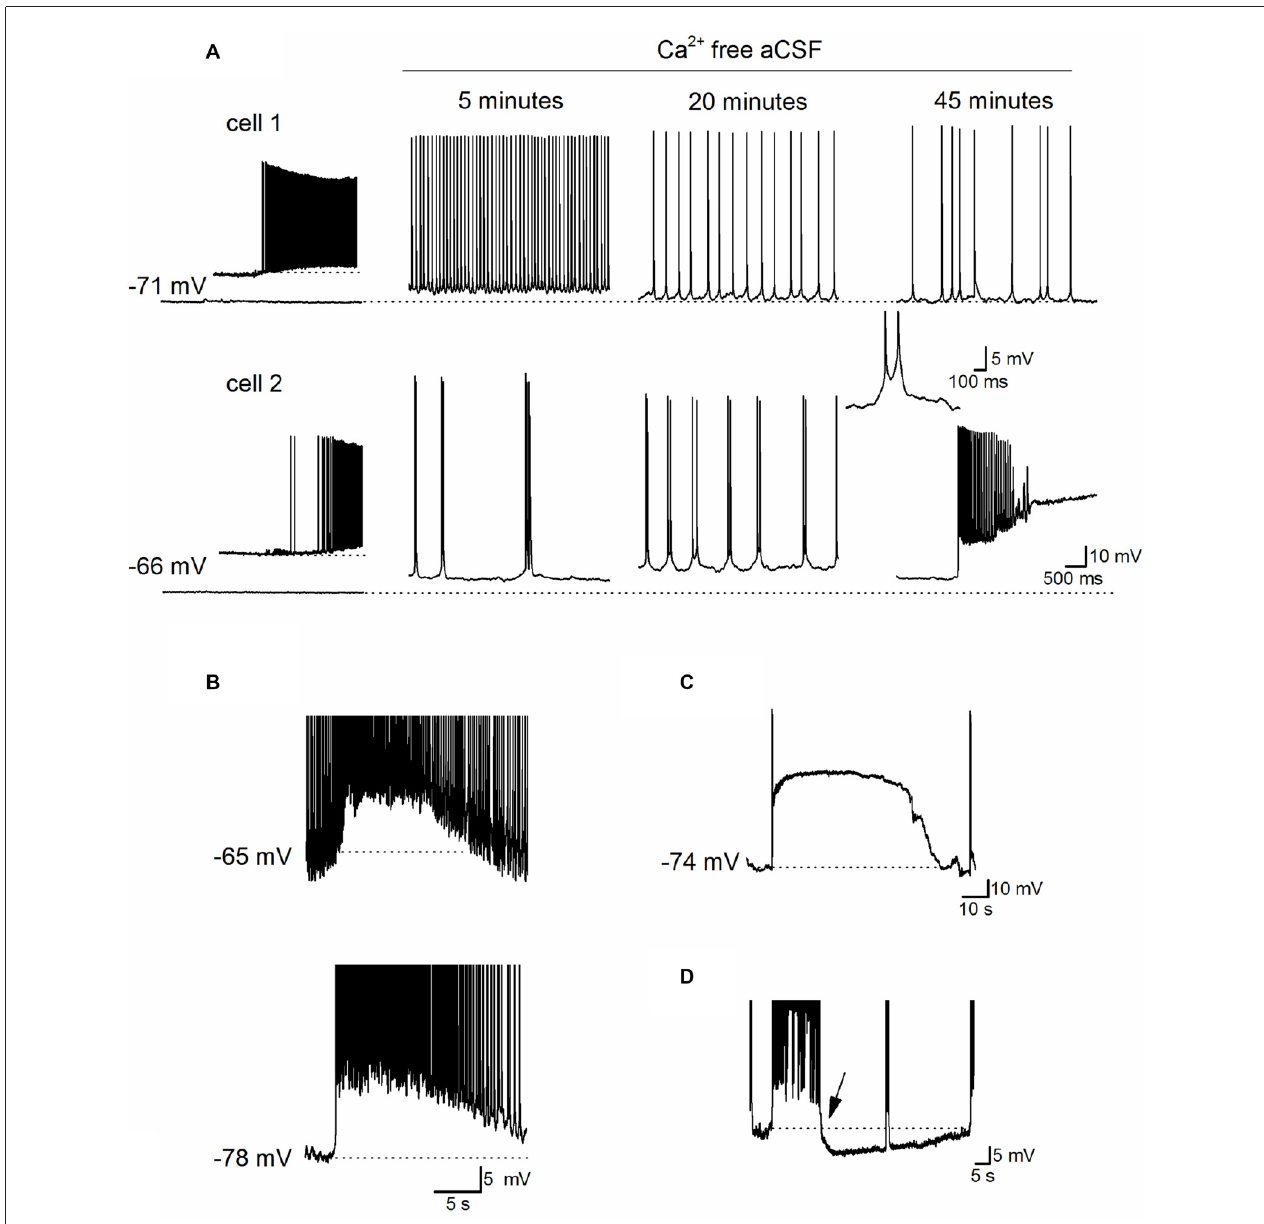
FIGURE 1 | Characterization of Ca 2 + free activity in the hippocampus. (A) Time-course of the effects of perfusing Ca 2 + -free aCSF (1 mM EGTA) on the activity recorded simultaneously from two pyramidal cells in area CA1 of the hippocampus. Inset: illustrates when Ca 2 + -free aCSF first began to induce neural activity in cell 1, and induces spontaneous events in cell 2 which maybe excitatory postsynaptic potentials (EPSPs). At 20 min, there are frequent short depolarizations with superimposed action potentials, a single example of such an event is illustrated in the inset (action potentials are truncated). After ∼ 45 min there was a rapid depolarizing shift in the membrane potential in cell 2 that was not observed in cell 1. (B) Recordings from a pair of pyramidal cells where there was a simultaneous depolarization in both cells with a very similar time course. The top cell was active whereas the bottom cell was quiescent before the depolarization occurred. (C) Example of a large rapid depolarizing shift in membrane potential leading to depolarization block. The membrane potential remained depolarized (at around − 16 mV) for ∼ 70 s, repolarized and the pyramidal cell resumed firing. (D) Following a strong burst of activity, a prolonged hyperpolarization occurred (starting at arrow, duration ∼ 50 s, dotted line is the membrane potential before the burst of activity). In (D) action potentials are truncated at − 40 mV and this recording was not performed simultaneously with that in (C) .